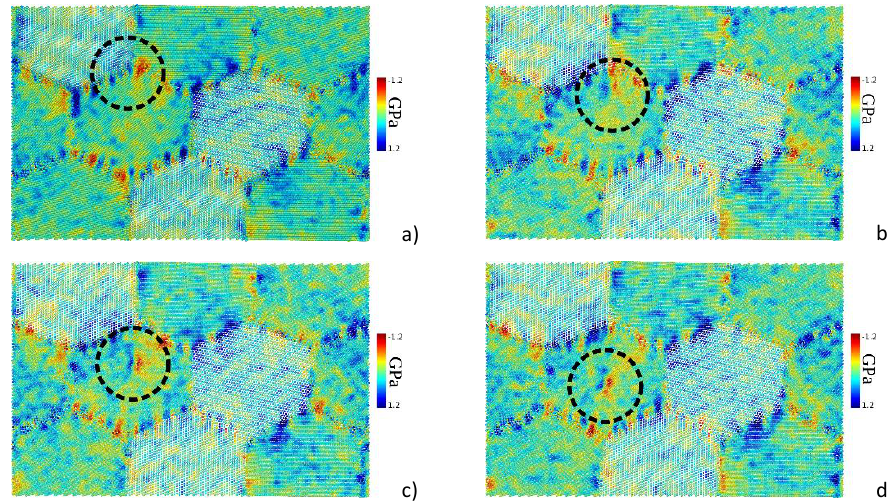
Fig. 3. YY stress distribution at different time points: a) 75, b) 85, c) 86, d) 87 ps. The dotted circle shows the area with partial dislocation creating stacking